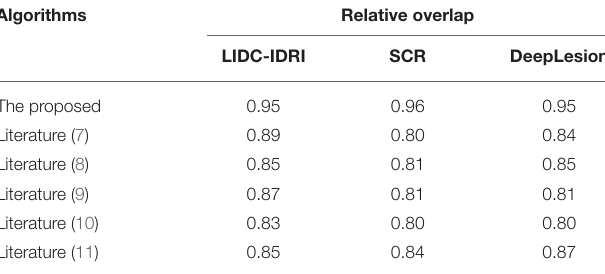
TABLE 1 | Comparison of the relative overlap of different algorithms.